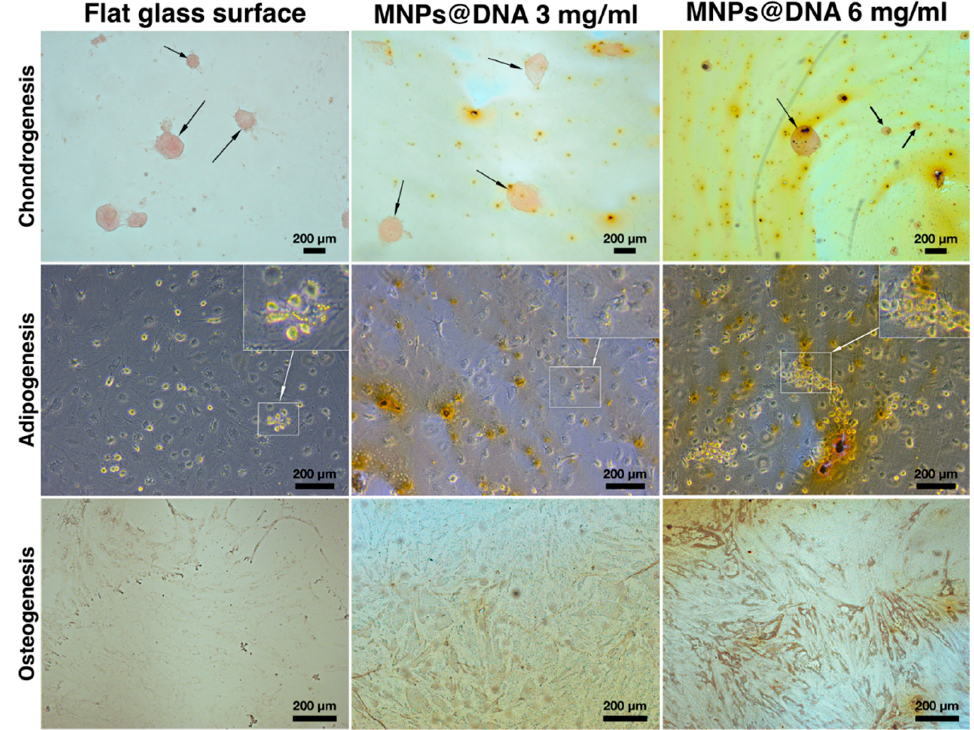
Figure 6. Differentiation of hTERT-transduced MSCs on 14 days of cultivation: chondrocytes were stained with safranin O, adipocytes—with Oil Red O, and osteoblasts—with silver nitrate (von Kossa stain). Arrows indicate chondrocyte aggregates. Areas of cells with lipid droplets are marked with squares.